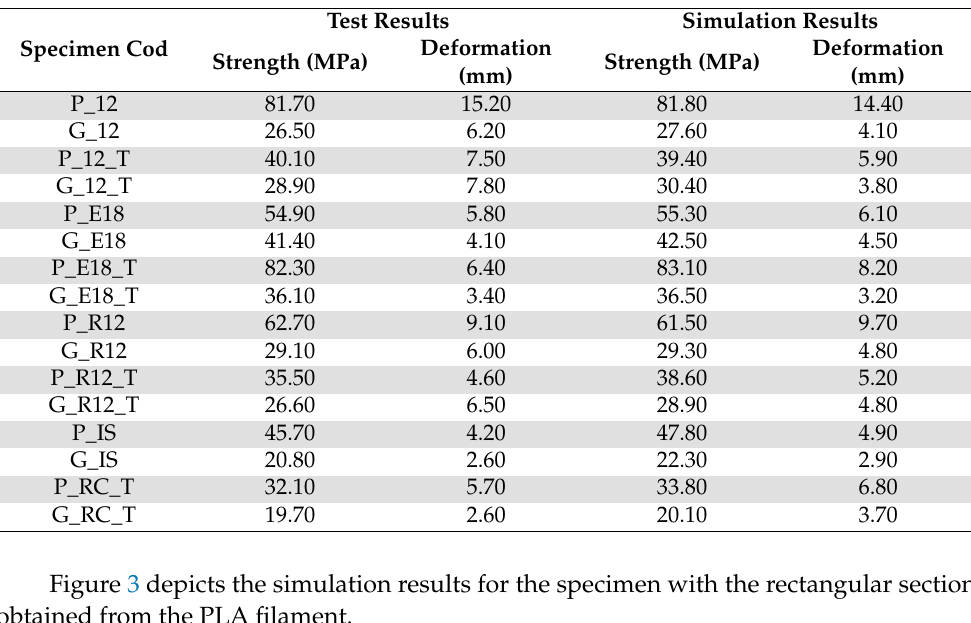
Figure 4. Results of simulation process for P_R12 specimen (total deformation values). In Figure 5, the simulation results for the tube-type specimen with rectangular sec- tion obtained from PLA filament is presented.